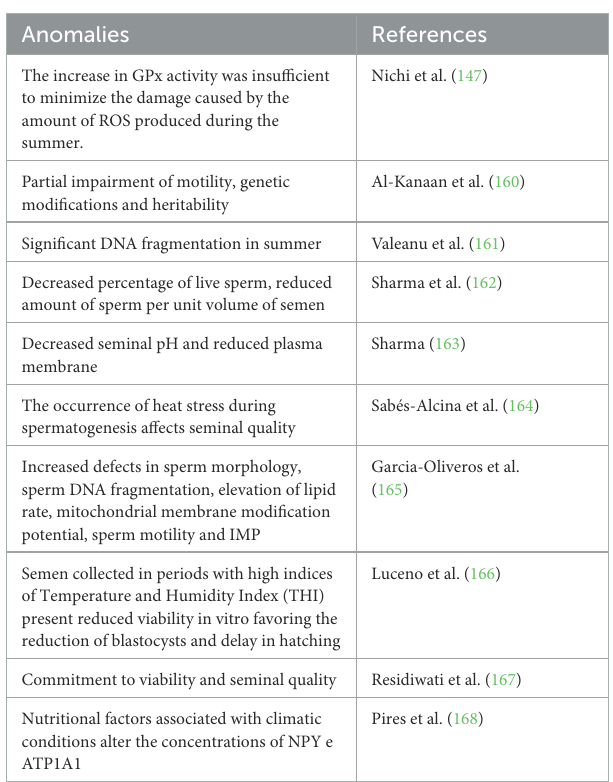
TABLE 6 Anomalies evidenced in sperm after heat stress in